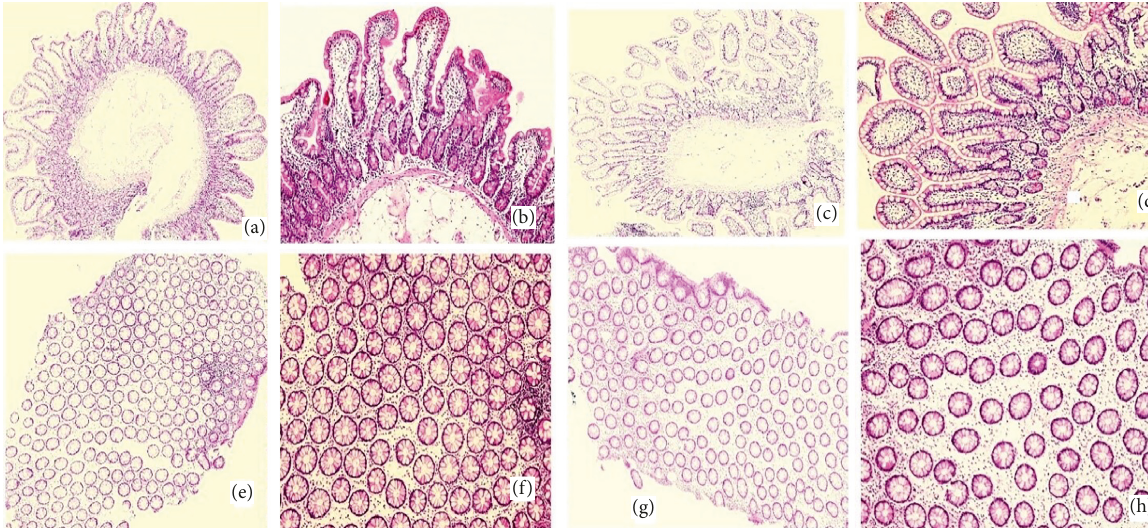
Figure 2: Light microscopic images (H&E staining). Normal duodenal lining: (a) (4X). (b) (10X). Normal ileal lining: (c) (4X). (d) (10X). Normal rectal lining: (e) (4X). (f) (10X). Normal lining of sigmoid colon: (g) (4X). (h)